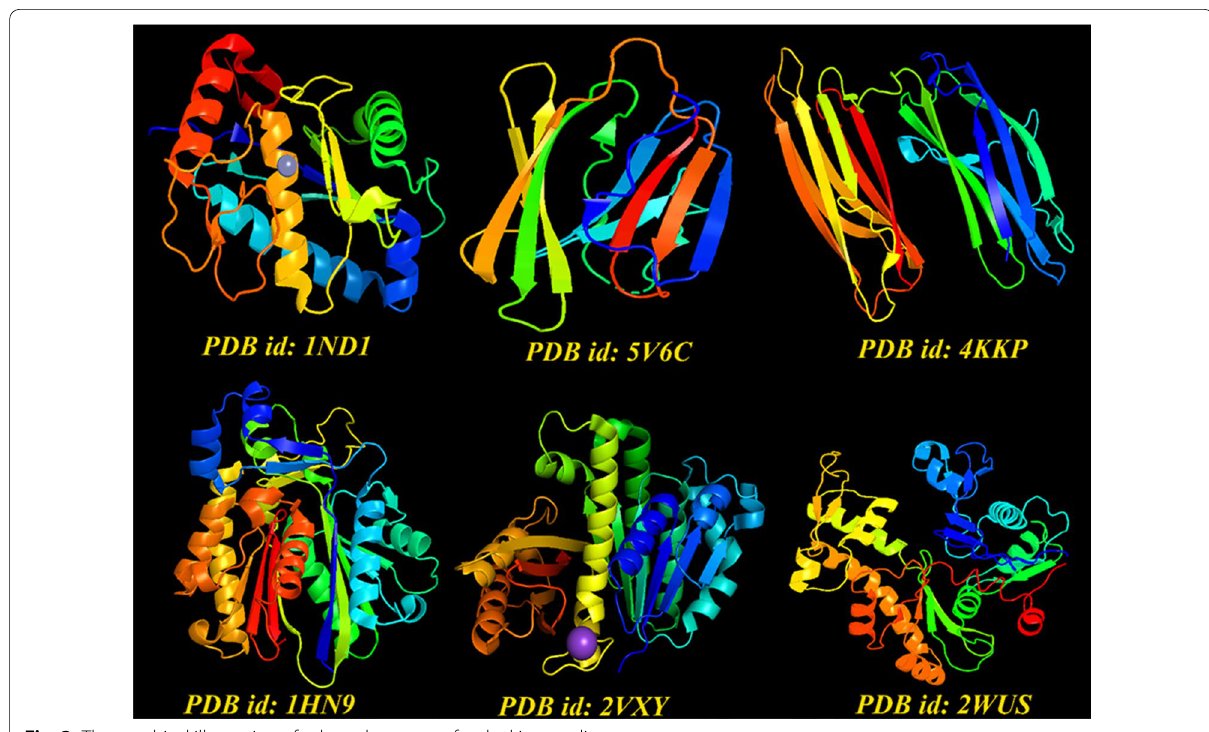
Fig. 3 The graphical illustration of selected receptors for docking